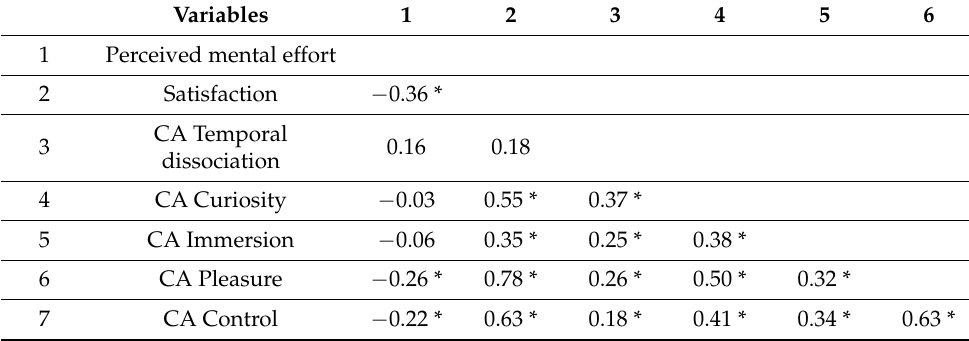
Table 3. Correlations between mental effort, satisfaction, and cognitive absorption dimensions.